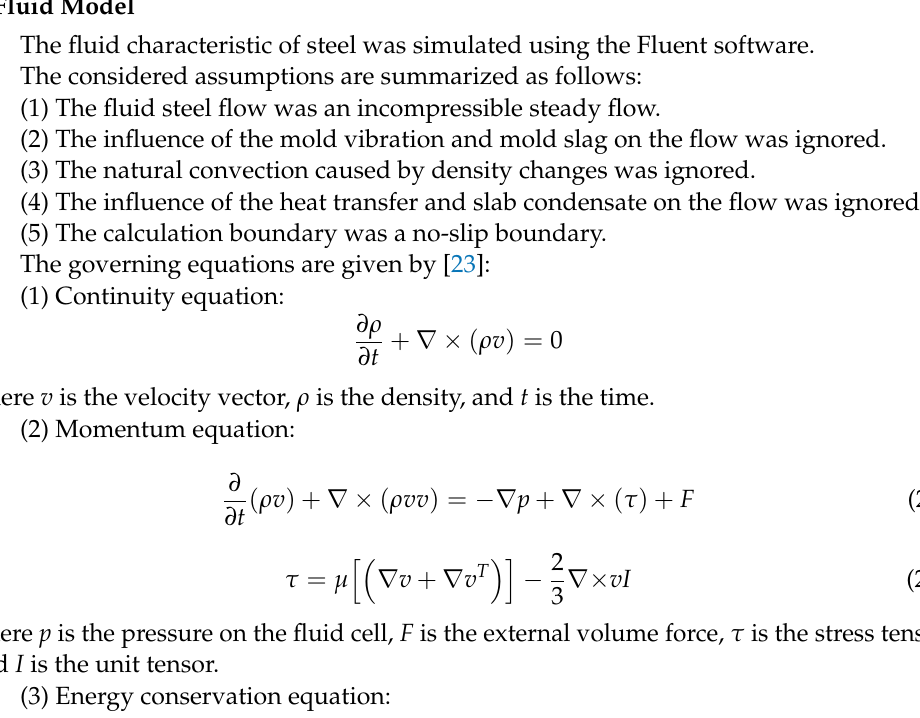
Figure 2. The structures of SEN.